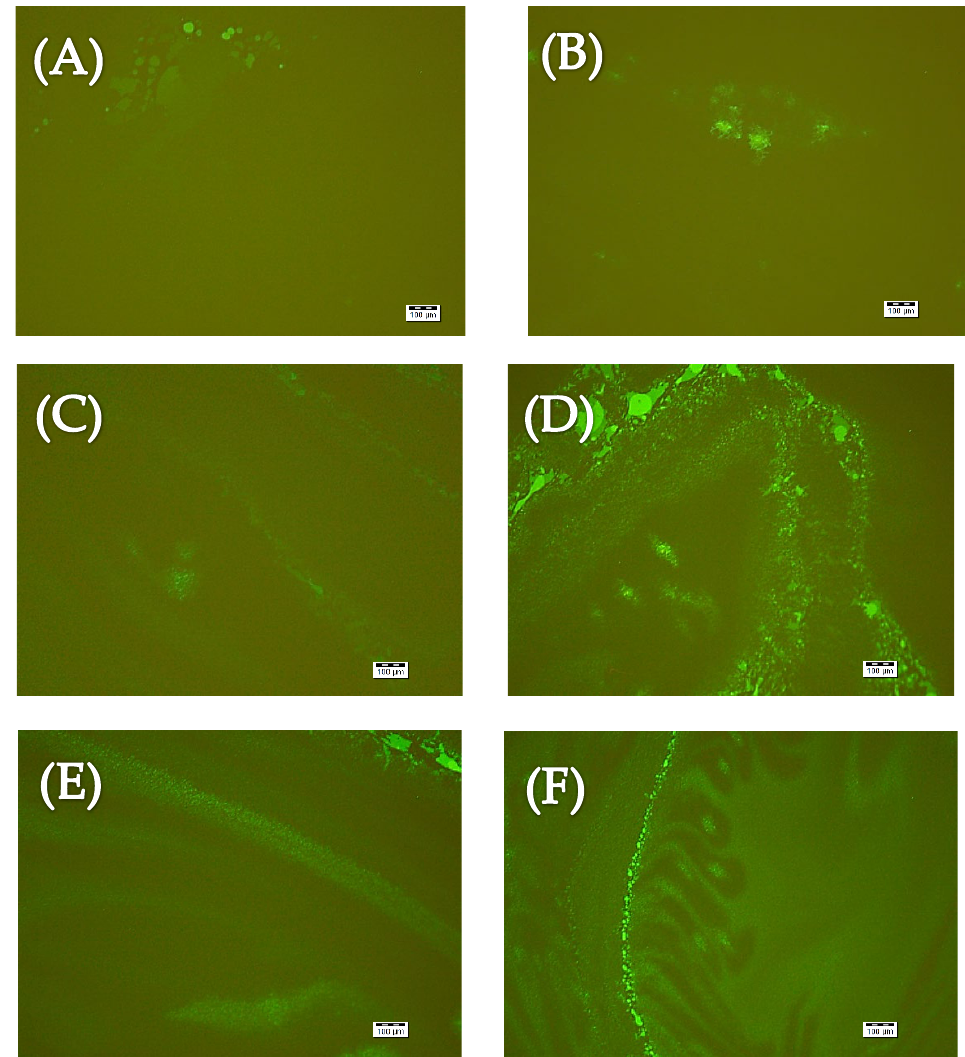
Figure 2. Microphotographs from fluorescence microscope of the synthetic sebum monolayer compressed to surface pressure ( π ) of: 9 mN/m ( A ), 13 mN/m ( B ), 19 mN/m ( C ), 22 mN/m ( D ), 30 mN/m ( E ) and 40 mN/m ( F ). Scale bar 100 μm. Table 1. Composition of real and synthetic sebum.